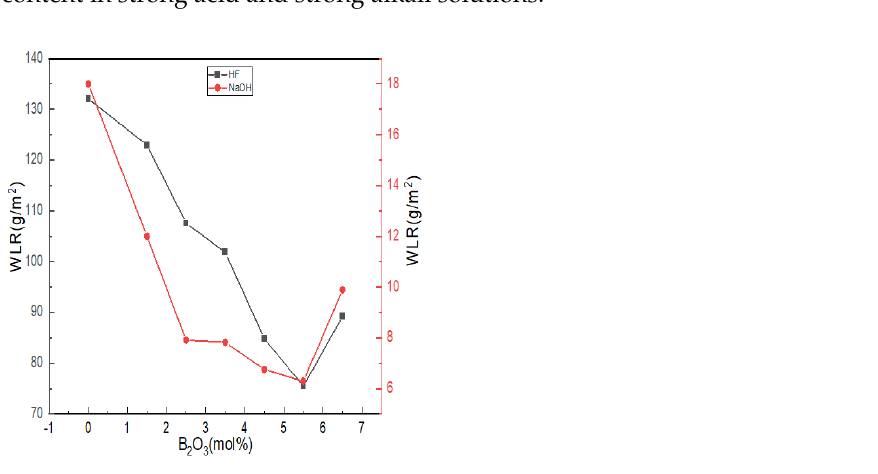
− Al − SiO 2 O 2 O 3 2 series glass with different